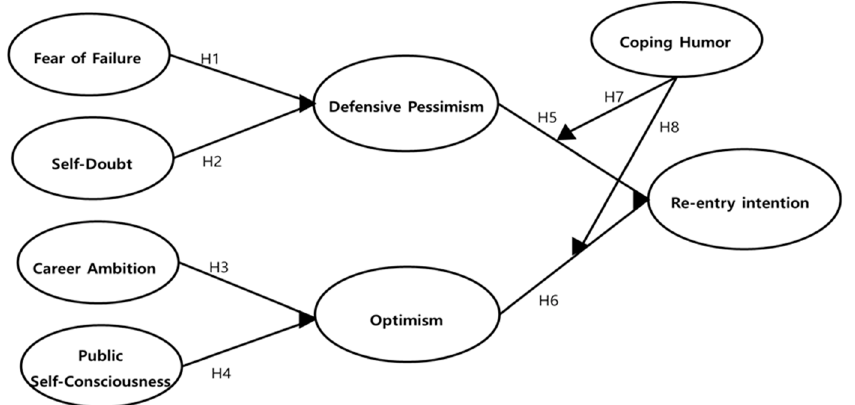
Figure 1. Proposed research